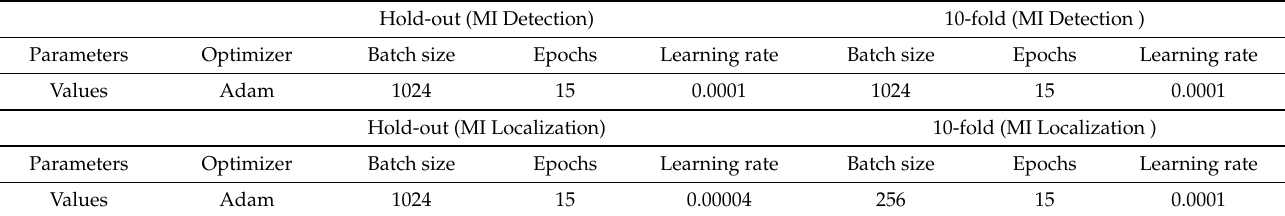
Figure 4. Proposed MMDCNN model to detect and localize MI using VCG beats. Table 2. Hyper-parameters used MI detection and localization using our proposed MMDCNN